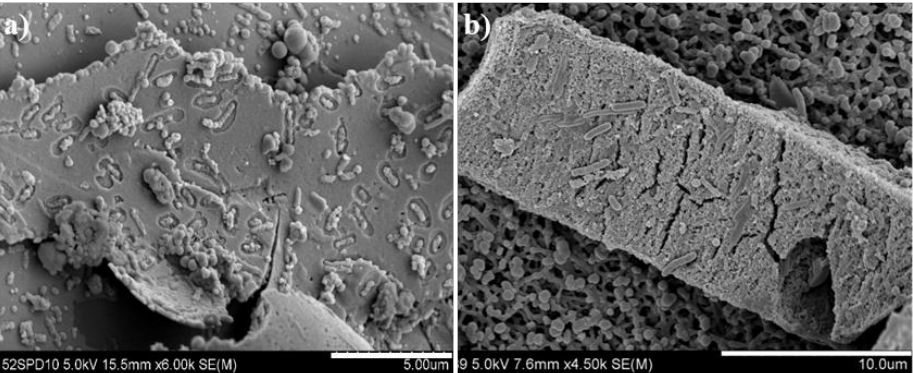
Figure 7. SEM images of pyrrhotite residues after completion of bioleaching under different initial pH conditions: ( a ) pH ini 2.8; ( b ) pH ini 3.2.